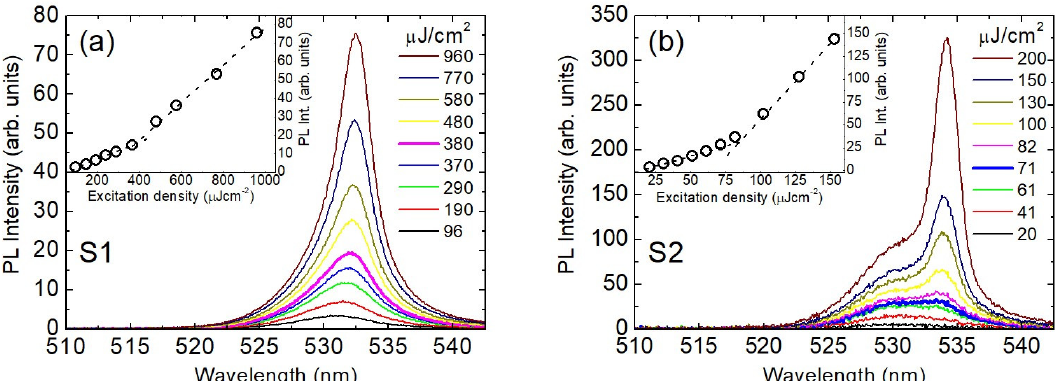
Figure 2. Excitation density dependence of the emission spectra of sample S1 ( a ) and S2 ( b ) recorded at 50 K, showing the progressive ASE band appearance. The thickest lines show the spectrum at the excitation density closest to the ASE threshold. Insets: excitation density dependence of the emission intensity at the peak ASE wavelength (symbols). Dotted lines are a guide for the eyes.